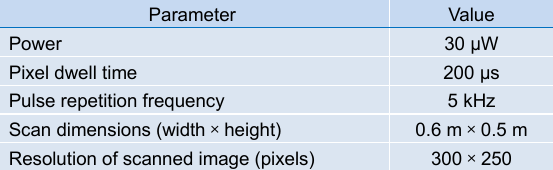
Table 2 | Key parameters for the depth profile measurement. Parameter Value Power 30 µW Pixel dwell time 200 µs Pulse repetition frequency 5 kHz Scan dimensions (width × height) 0.6 m × 0.5 m Resolution of scanned image (pixels) 300 ×